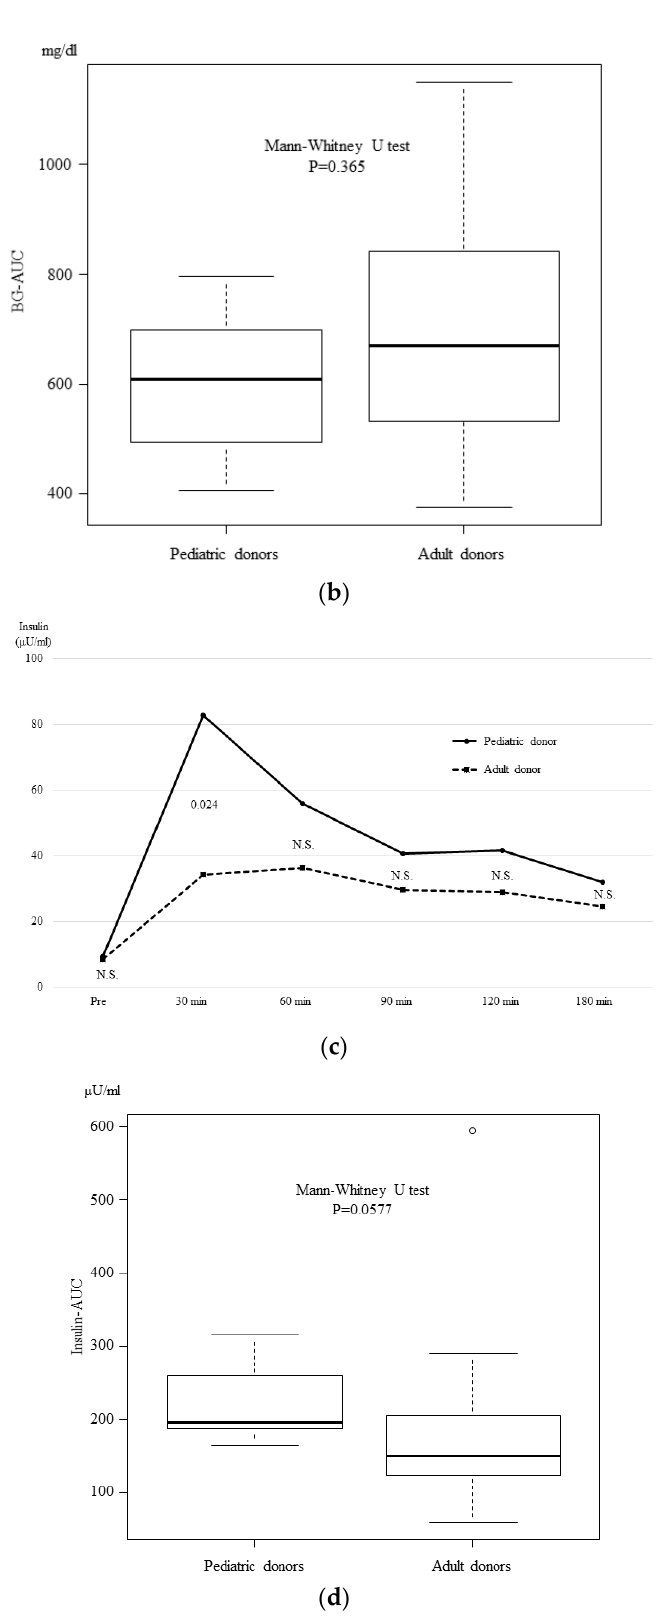
Figure 4. The 75 g Oral glucose tolerance test (OGTT) results at one month post-transplantation. The changes in blood glucose concentration ( a ) and the area under the curve (AUC) ( b ) did not differ between the two groups. However, the change in the serum insulin concentration ( c ) at 30 min after 75 g glucose loading was significantly higher in the PD group. As a result, although there was no significant difference, the AUC for insulin ( d ) tended to be higher in the PD group.